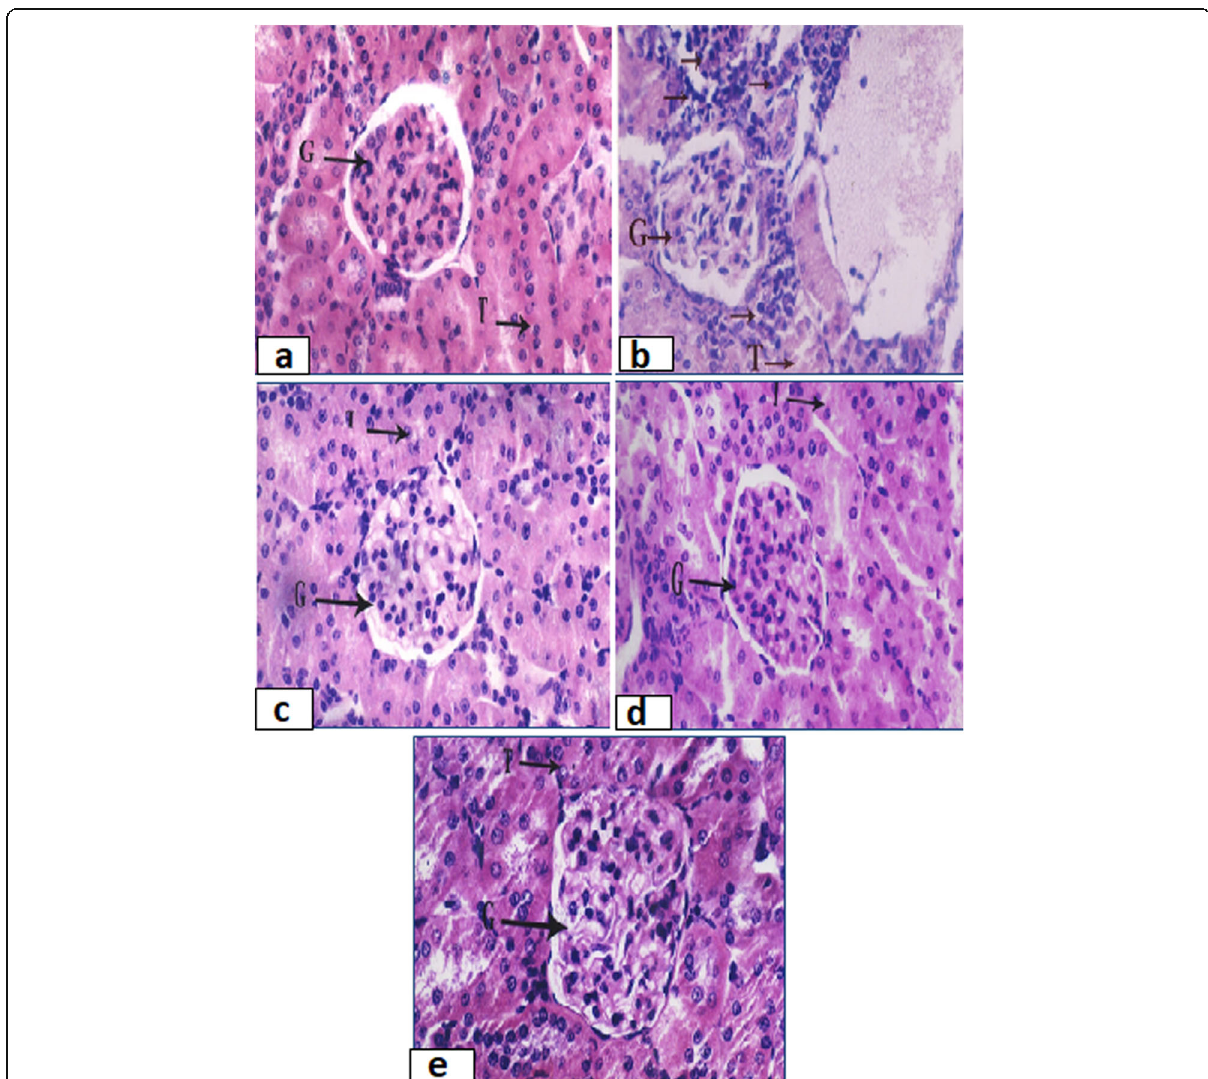
Fig. 5 Photomicrographs of kidney sections from control and treated groups, stained with hematoxylin and eosin H&E (10X). Kidney section of control group showing normal architecture of kidney tubule (T) and glomerulus (G) ( a ). Kidney section of AlCl3- treated group showing intensive inflammatory infiltration (arrow) and shrinkage of glomerulus (G) ( b ). Kidney section of propolis treated group showing normal architecture of kidney tubule (T) and glomerulus (G) ( c ). Kidney section of AlCl3 combined with propolis treated group showing recovered glomerulus (G) and no inflammatory cells were detected as compared to aluminum treated group ( d ). Kidney section of the AlCl3 treatment for one month followed by administration of AIC13 combined with propolis for another month group showing the protective role of propolis since no glomerular shrinkage or inflammatory cells were detected ( e